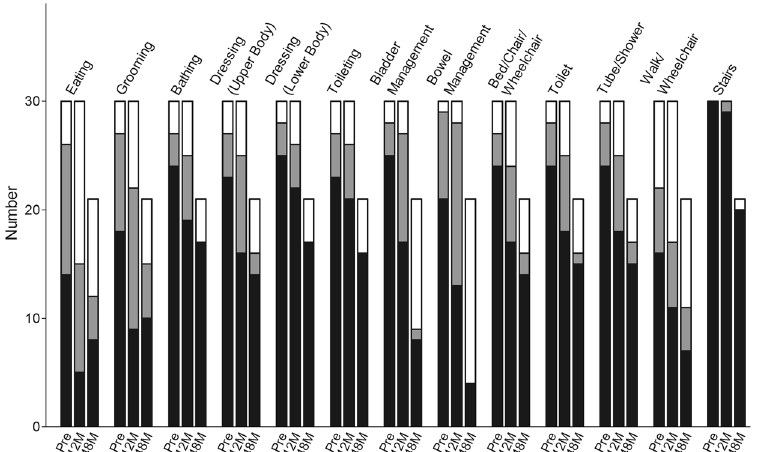
Figure 9. Numbers of different levels of dependence at each time point in the cervical group, translated from the Functional Independence Measure. Black bar = complete dependence on the helper; grey bar = modified dependence on the helper; white bar = no dependence on the helper.